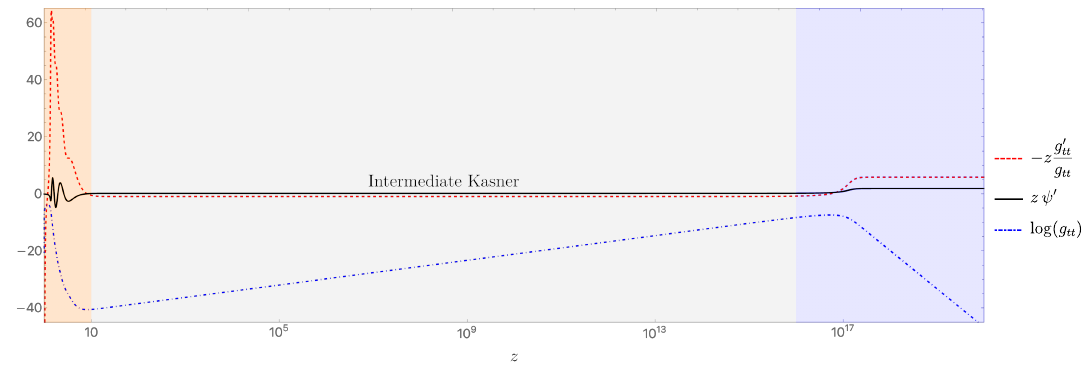
Figure 5 . Typical example of the full dynamical evolution of a system with a Kasner transition like the ones observed in figure 4. The system evolves from the event horizon at z = 1 towards the final singularity at z → ∞ . In 1 < z < 10 (yellow shaded area) the system goes quickly through the ER bridge collapse and Josephson oscillations epoch, then it stays relatively steady for a long time z (but short proper time) in the intermediate Kasner regime with β ∼ . 1721212 , and finally (blue shaded area) there is a Kasner transition to β new ∼ 1 . 848235 . This is for α = 1 , q = m, mM = 0 . 5 , Q/Q c − 1 = 5 . 861297 × 10 − 5